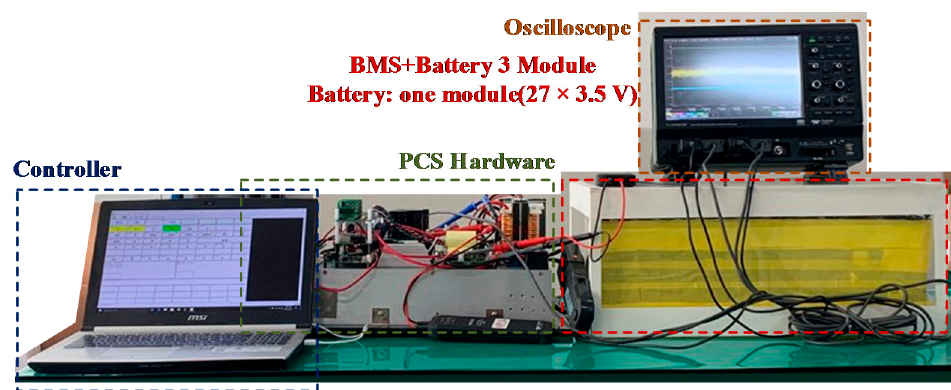
Figure 13. The experimental hardware configuration of ESS. Table 1. The experimental parameters for ESS.